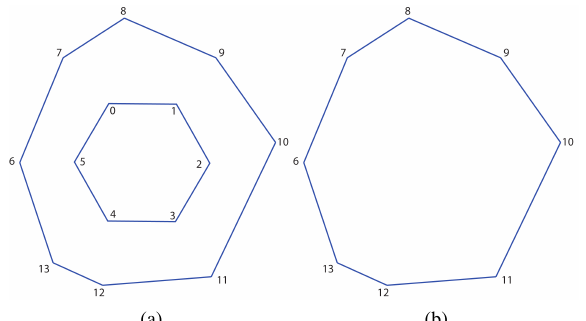
Figure 10: Removal of the internal perimeter.